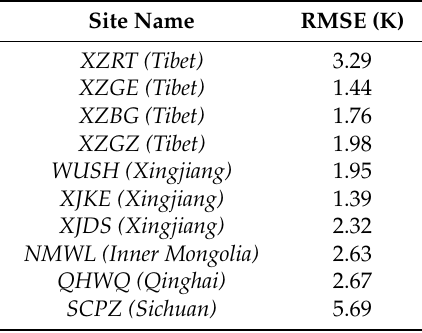
Table 5. RMSE between T m_IW and T m_OW at CMONOC GNSS stations without nearby meteorological